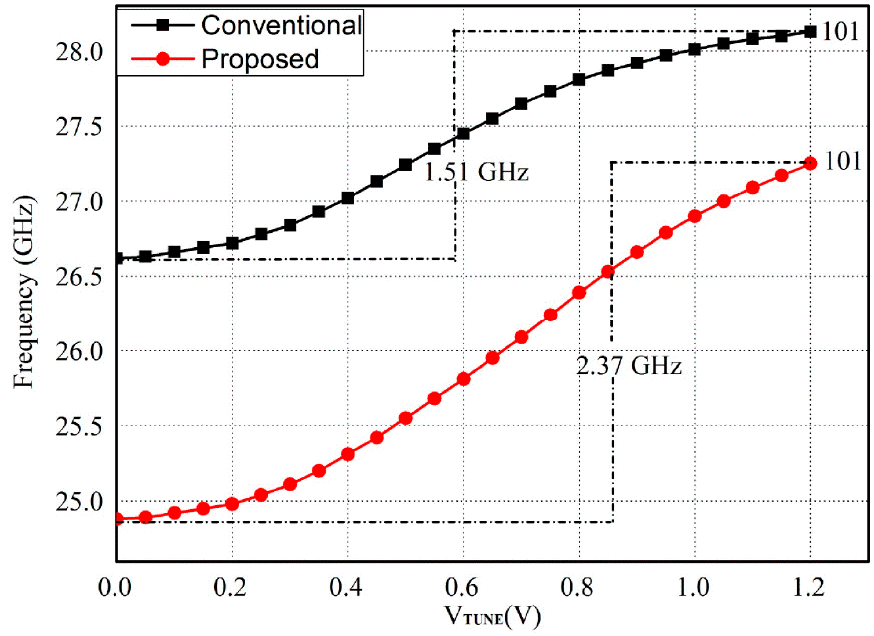
Figure 4. Simulated single frequency tuning characteristic using conventional and proposed varactors.